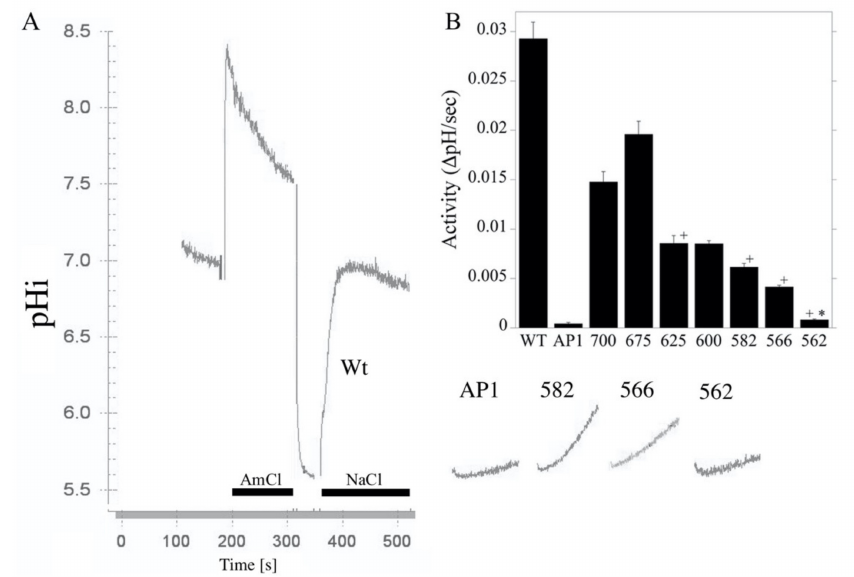
Figure 3. Activity of wild type NHE1 and mutants NHE-562, NHE-566, NHE-582, NHE-600, NHE-625, NHE-675 and NHE-700. ( A ) example of the activity of stably transfected cells. Acidosis was